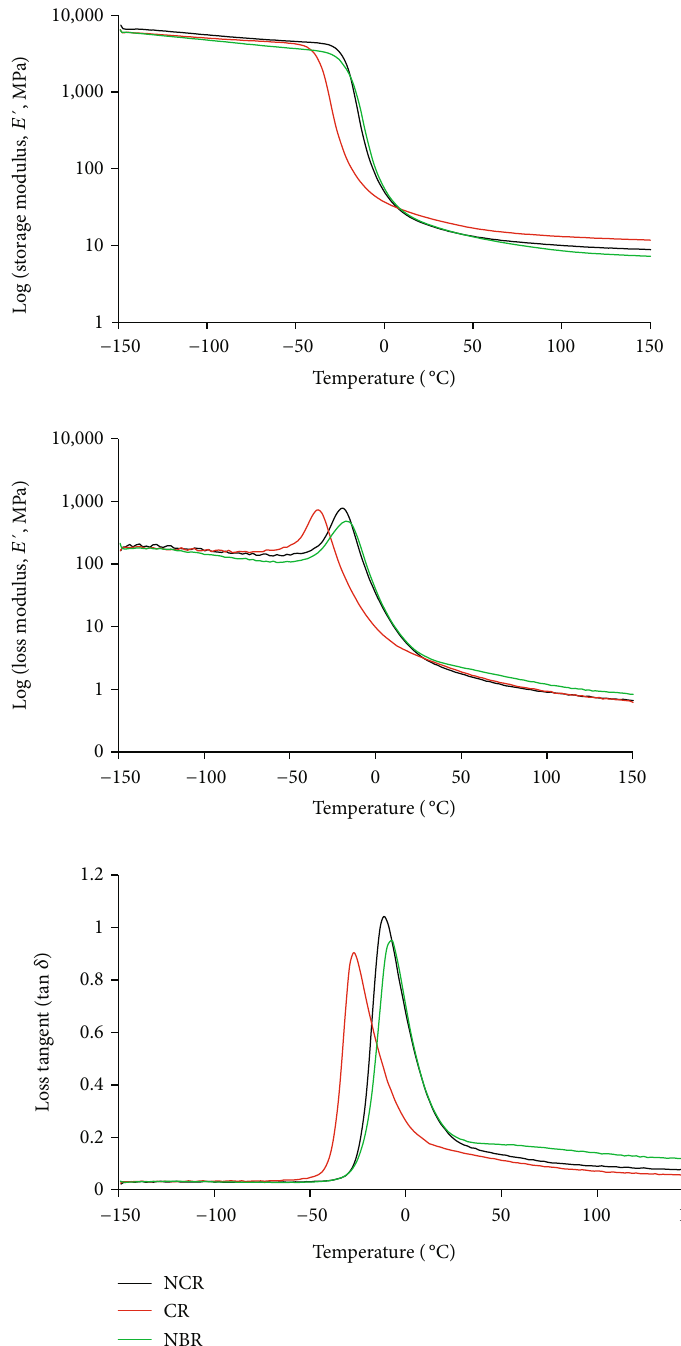
Figure 6: DMTA results on vulcanizates of acrylonitrile-chloroprene rubber (NCR), chloroprene rubber (CR), and nitrile rubber